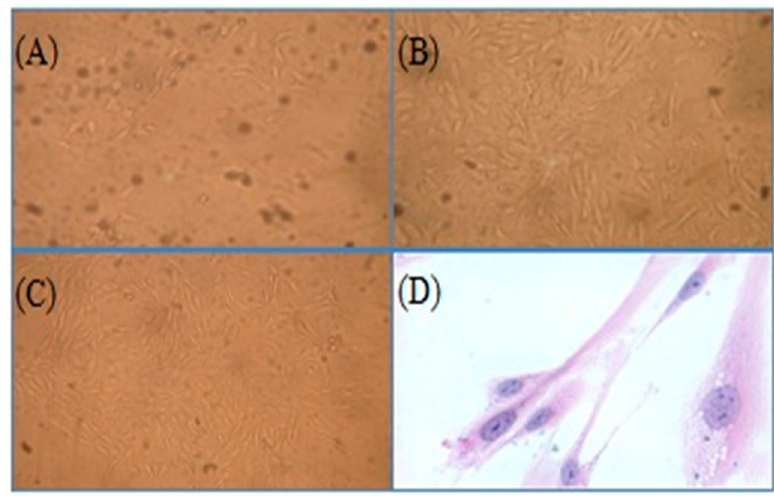
Figure 5. Synoviocyte purification and identification (magnification = 200×). Before purification ( A ); the first passage of type B synoviocytes ( B ); the purified synoviocytes ( C ) and the stained synoviocytes ( D ).